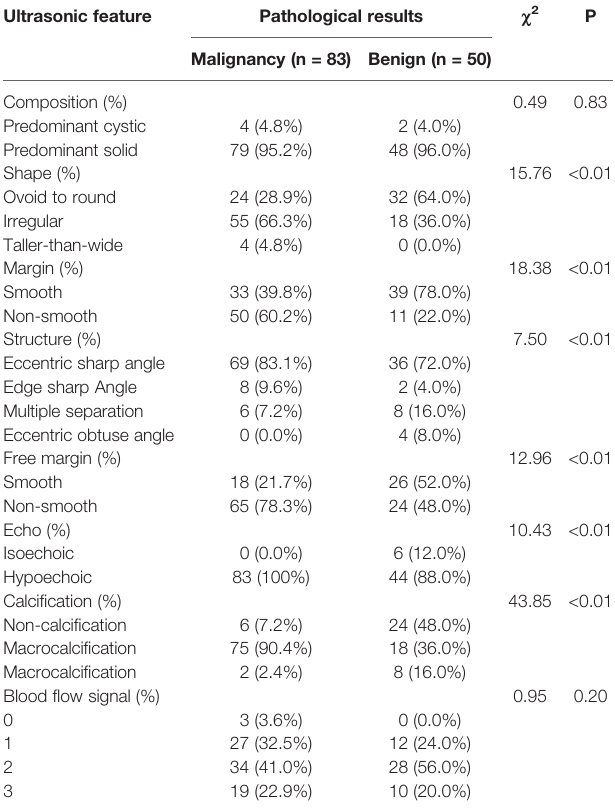
TABLE 2 | Ultrasound characteristics of the partial cystic nodules of the thyroid gland. Ultrasonic feature Pathological